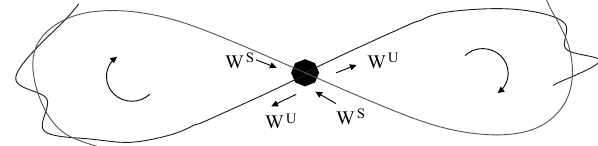
Fig. 2. Perturbed homoclinic orbits Eq. (8): stable and unstable manifolds ( W S and W U ).